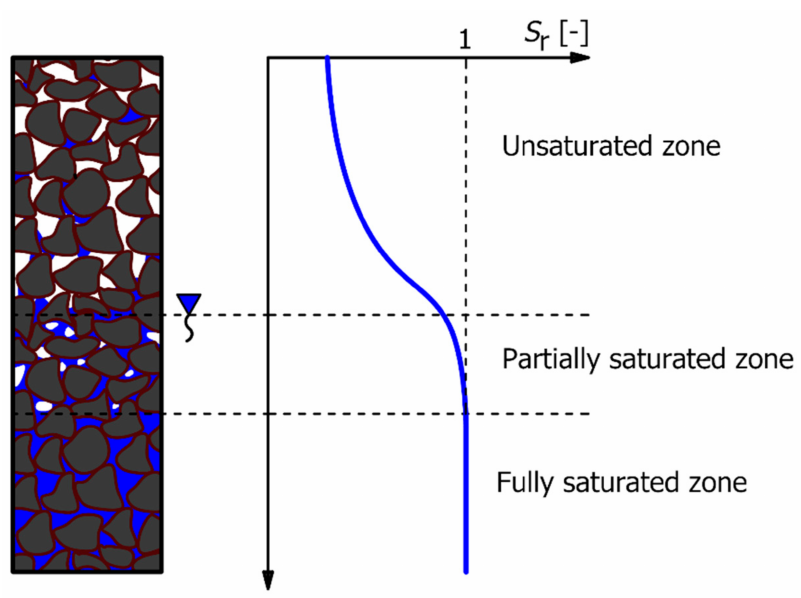
Figure 2. Saturation distribution in a soil medium.